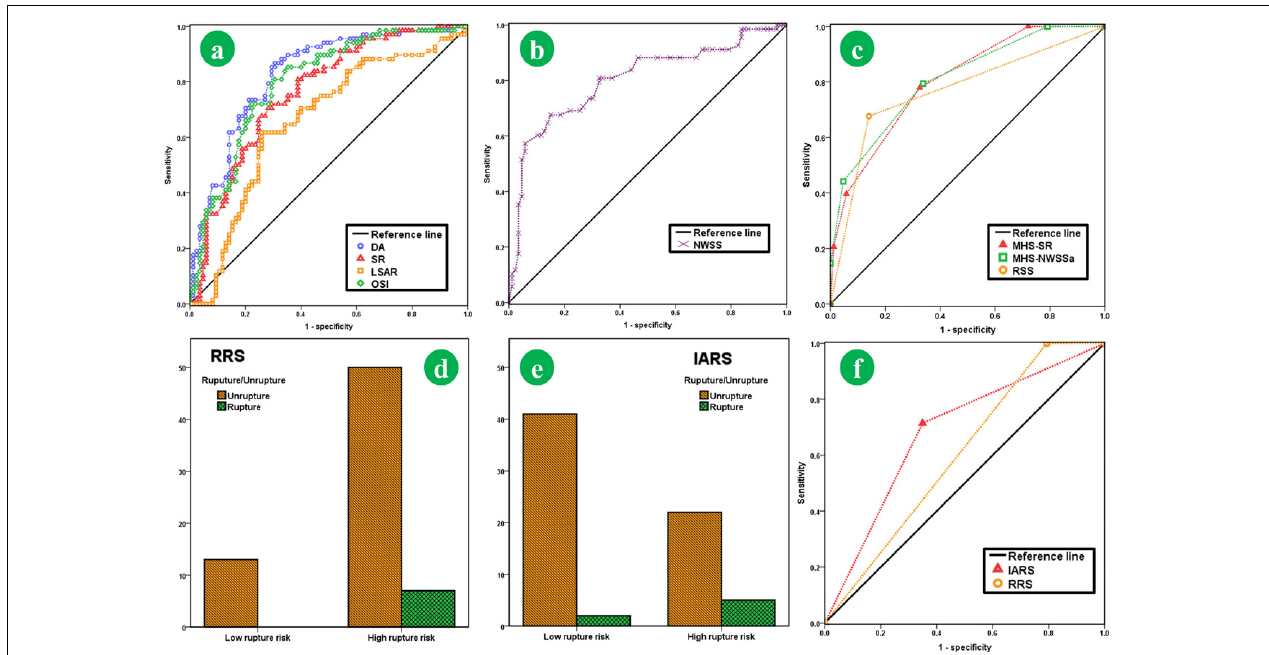
FIGURE 4 | The ROC curves of key parameters (DA, SR, LSAR, OSI, and NWSS) were presented here (a,b) . The cut-off values for SR, DA, NWSSa, LSAR, OSI, and RRT were 2.3, 35, 0.24, 0.30, 0.008, and 5.3, respectively. The ROC curves of the IARS-SR, IARS-NWSS, and RRS suggested that the AUC of IARS-SR (AUC 0.81) was larger than IARS-NWSS (AUC 0.79) and RRS (AUC 0.77), which suggested that the IARS-SR had higher accuracy to discriminate the ruputre statue (c) . For the follow-up group, the distributions of the ruptured aneurysm and unruptured aneurysm in each stratification system were presented (d,e) . The IARS has higher AUC (AUC for the IARS and the RRS was 0.723 and 0.673, respectively.